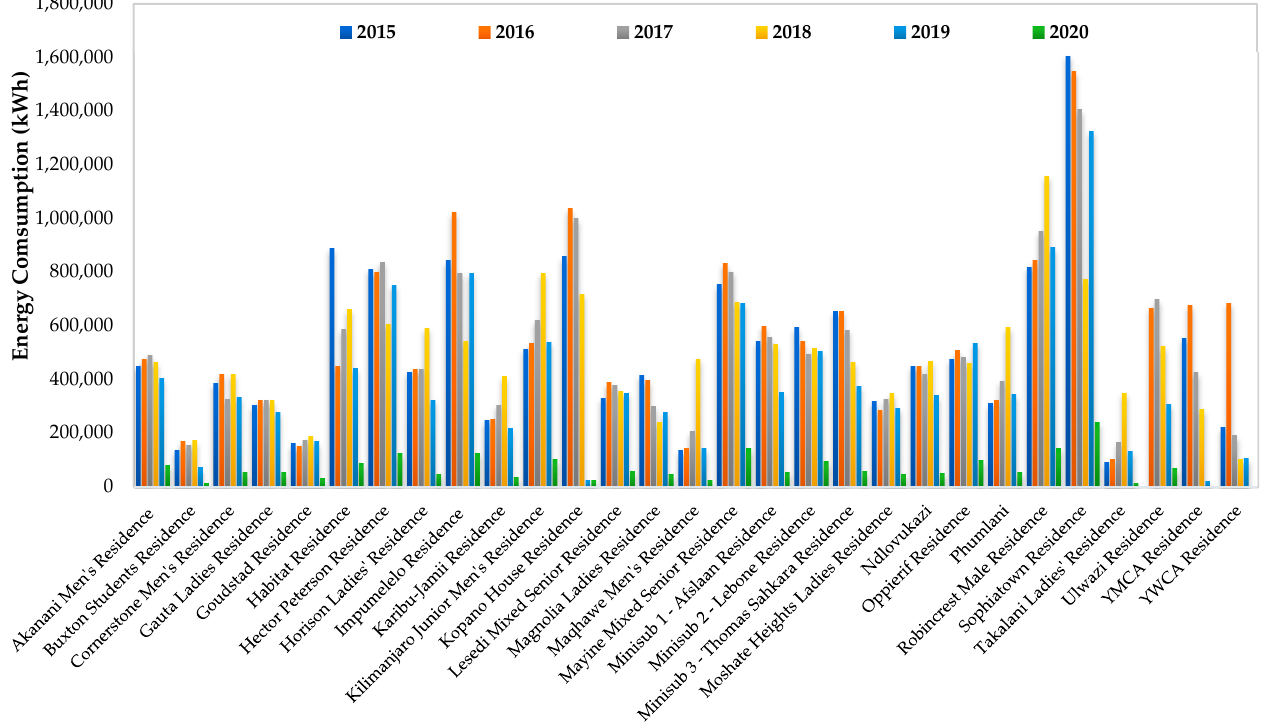
Figure 3. Annual energy consumption by each UJ-Res from 2015 to 2020.